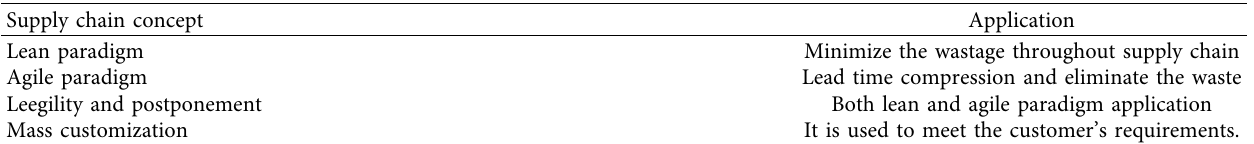
Table 4: Supply chain concept and its